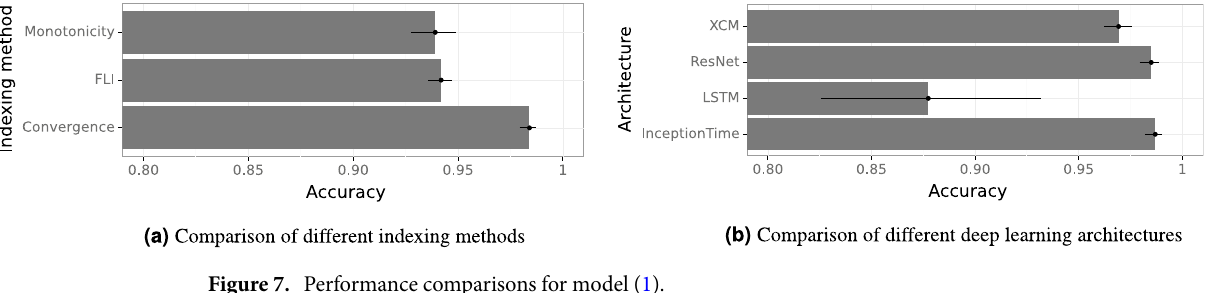
Figure 7. Performance comparisons for model